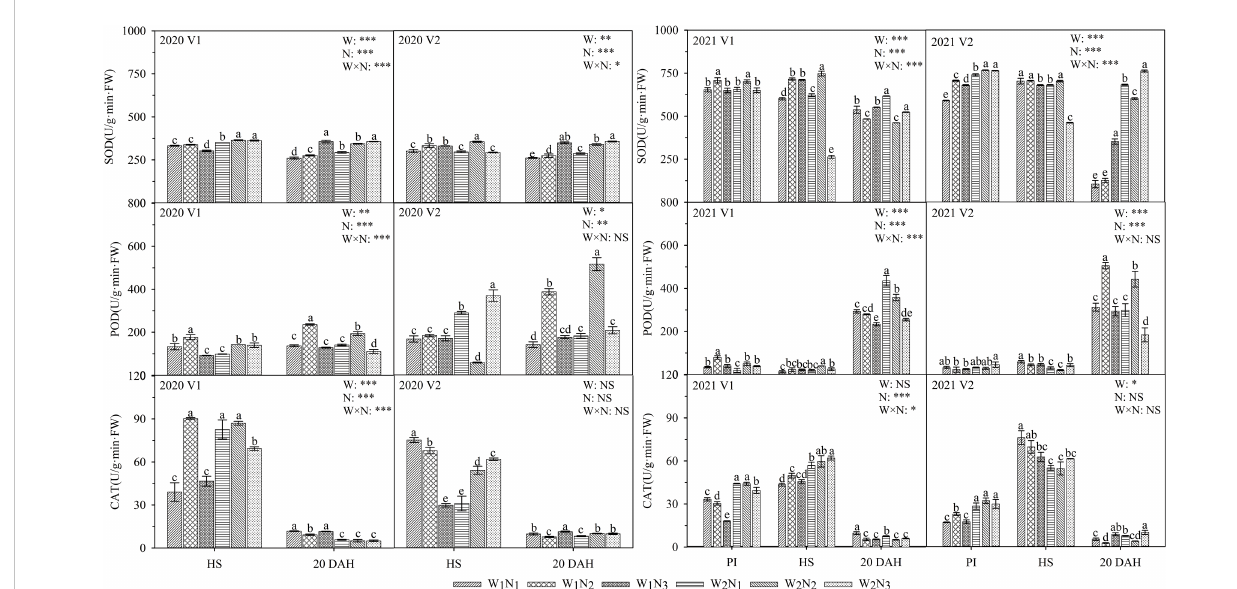
FIGURE 7 Effects of different water and nitrogen treatments on antioxidative enzyme activities in rice leaves at different growth stages. The data are presented as the means of three replicates (n = 3). Error bars indicate standard error (SE). W 1 and W 2 represent limited irrigation (10200 m 3 ·hm -2 ) and de fi cit irrigation (8670 m 3 ·hm -2 ), while N 1 , N 2 , and N 3 represent different ratios of seedling fertilizer:tillering fertilizer:panicle fertilizer:grain fertilizer (30%:50%:13%:7%; 20%:40%:30%:10%; and 10%:30%:40%:20%, respectively). PI, HS, and 20 DAH represent panicle initiation, heading stages, and 20 days after heading, respectively. V1 and V2 represent T-43 and Liangxiang-3, respectively. * represents a signi fi cant difference at the 0.05 level; ** represents a signi fi cant difference at the 0.01 level; *** represents a signi fi cant difference at the 0.001